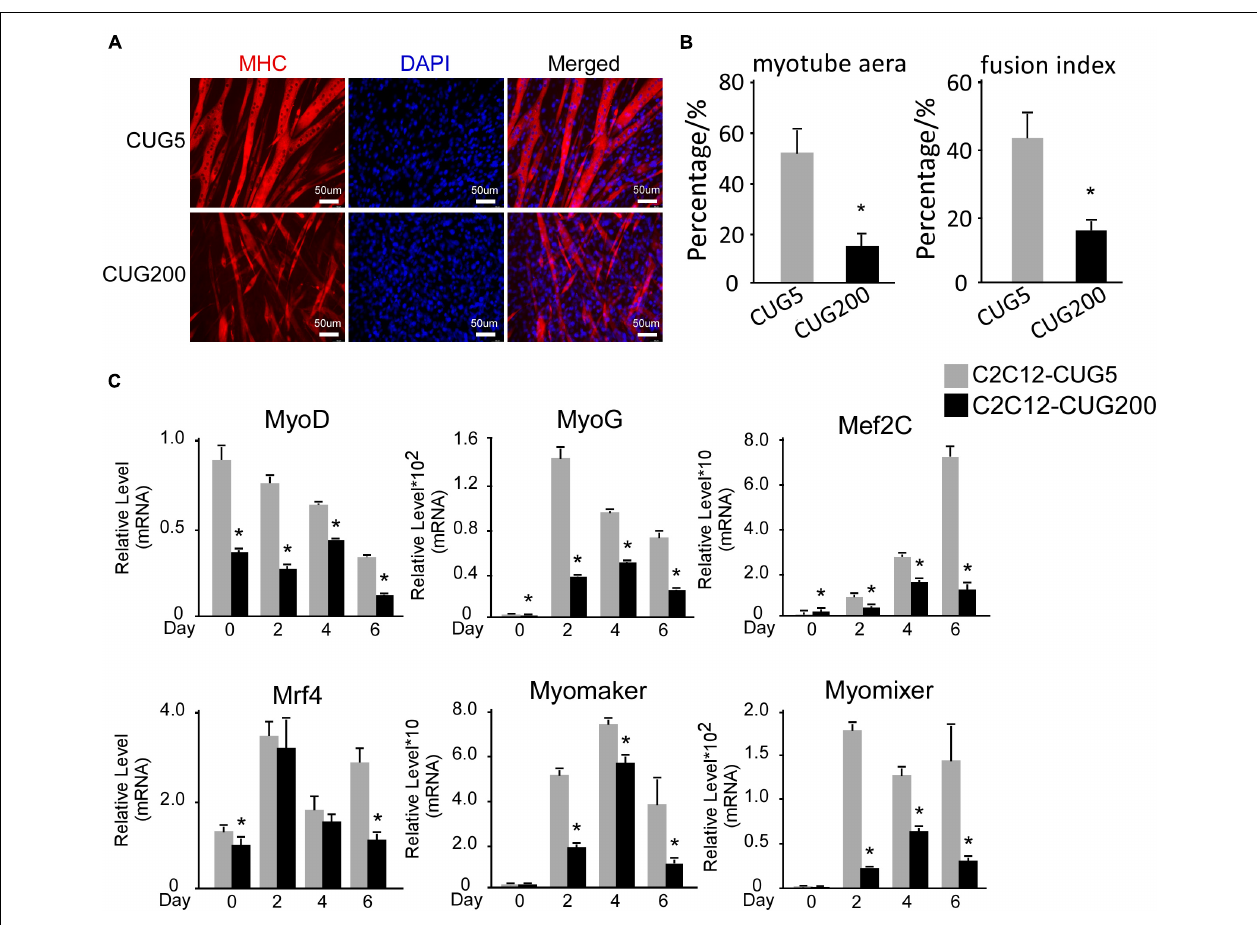
FIGURE 1 | Myogenesis was significantly impaired in the myotonic dystrophy type 1 (DM1) myoblast cell model. (A) Myotube formation by myoblast cells of both normal control and DM1 groups, detected by immunostaining against myosin heavy chain (MHC) at differentiation day 6. (B) Myotube area and fusion index in both the normal control and DM1 groups quantified with ImageJ software. (C) Expression levels of myogenic regulatory factors (MRFs; MyoD , MyoG , Mef2C , and Mrf4 ) and fusion markers ( Myomaker and Myomixer ) in normal control, and DM1 groups, measured by real-time quantitative PCR (RT-qPCR). All expression levels were normalized to the values of the normal control group at day 0. CUG5, normal control myoblast cells (C2C12 GFP-CUG5); CUG200, DM1 myoblast cells (C2C12 GFP-CUG200); * P <